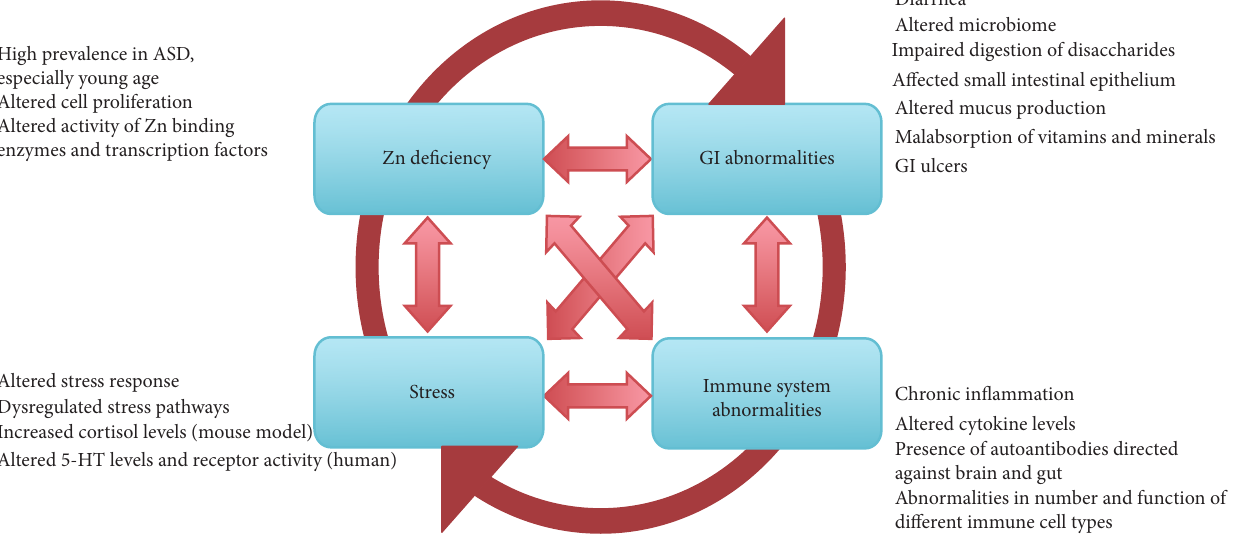
Figure 2: GI abnormalities, immune system dysfunction, stress, and zinc deficiency may be highly linked processes contributing to the development of ASD. Zinc deficiency mediates GI system abnormalities, severely affects many components of the immune system, and is linked to physiological and psychological stress. Although there is good reason to believe that maternal zinc deficiency might be the initial trigger, once this vicious cycle is activated in the offspring, GI abnormalities, impaired immune system, stress, and zinc deficiency can be both cause and consequence of each other and influence the development of ASD. This is in line with the often reported symptoms and comorbidities in ASD associated with problems linked to these four key